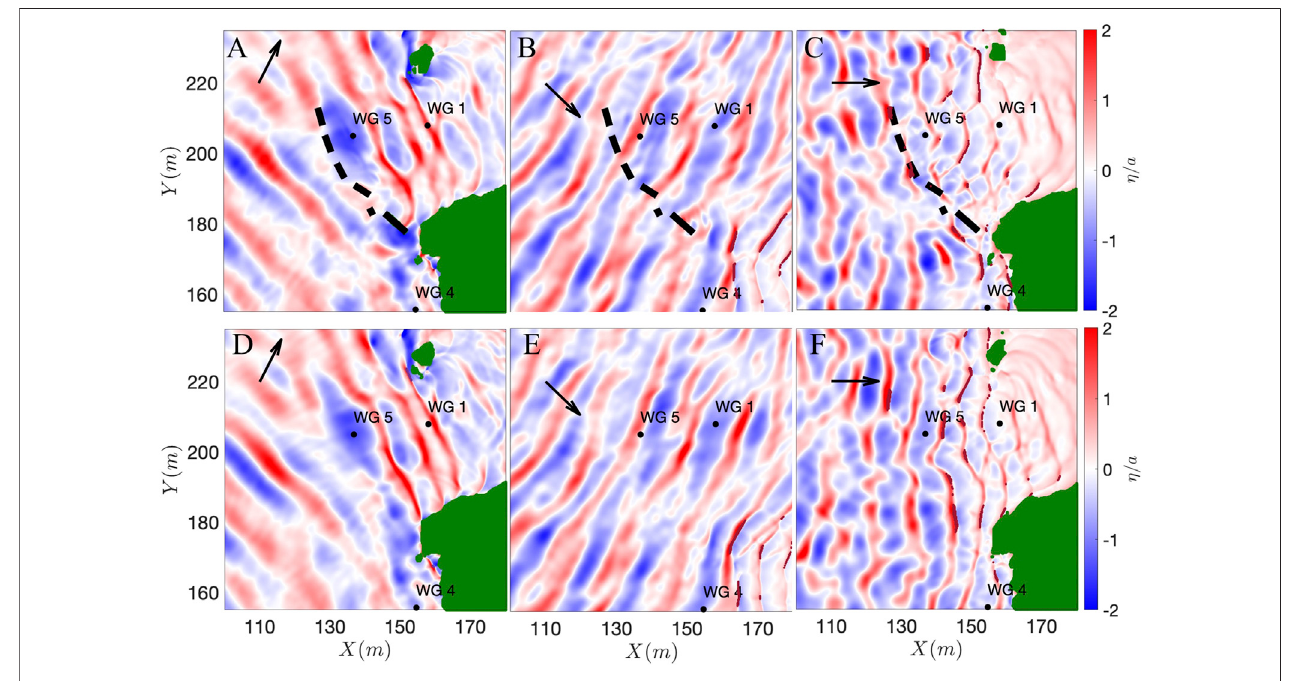
FIGURE 7 | Water surface elevation snapshot to wave amplitude ratio for (A,D) Case 1, (B,E) Case 2, and (C,F) Case 3. In panels (A – C) CORs are present in the domain, while in panels (D – F) CORs are removed from the domain. Dark red lines on the fi gures denote wave breaking at those locations.